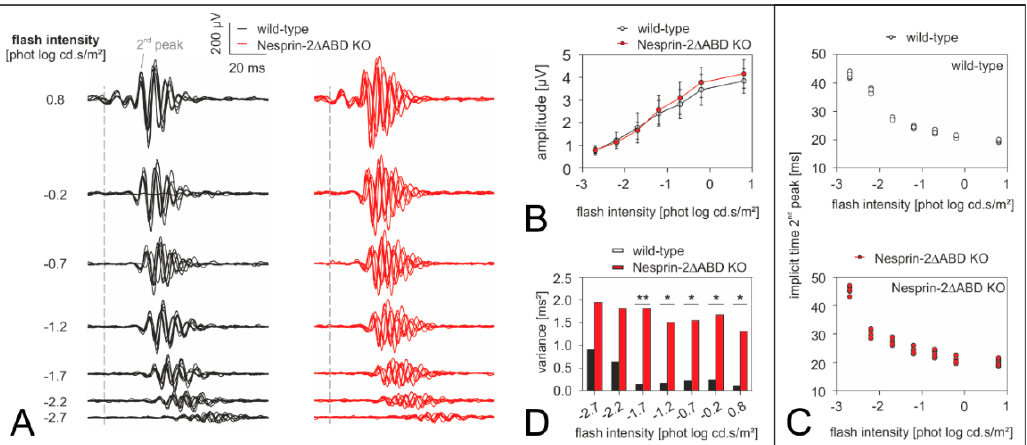
Figure 5. Analysis of the oscillatory potentials isolated from the scotopic flash-ERG in the retina of Syne-2 / Nesprin-2 KO mouse strain (age 2–4 month). ( A ) Individual oscillatory potential traces from each wild-type (black curves, n = 7) and Syne-2 / Nesprin-2 KO mouse (red curves, n = 7) are shown for each scotopic flash intensity. Note that the curves were more varied in time (i.e., less synchronized) within the Syne-2 / Nesprin-2 KO group. As such, group averaged (mean ± sd) intensity-response amplitudes of the 2nd oscillatory peak are shown in ( B ), whereas individual implicit times plots are displayed in ( C ) so as to better visualize the spread in each group. Although both wild-type and Syne-2 / Nesprin-2 KO implicit time profiles exhibited the same trend with increasing flash intensity, the inter-individual variability was larger in the Syne-2 / Nesprin-2 KO group. This was more obvious when ( D ) the variances of the implicit times of the two mouse groups were compared. Statistical significance is denoted with a * p < 0.05 or ** p < 0.005 (Levene’s